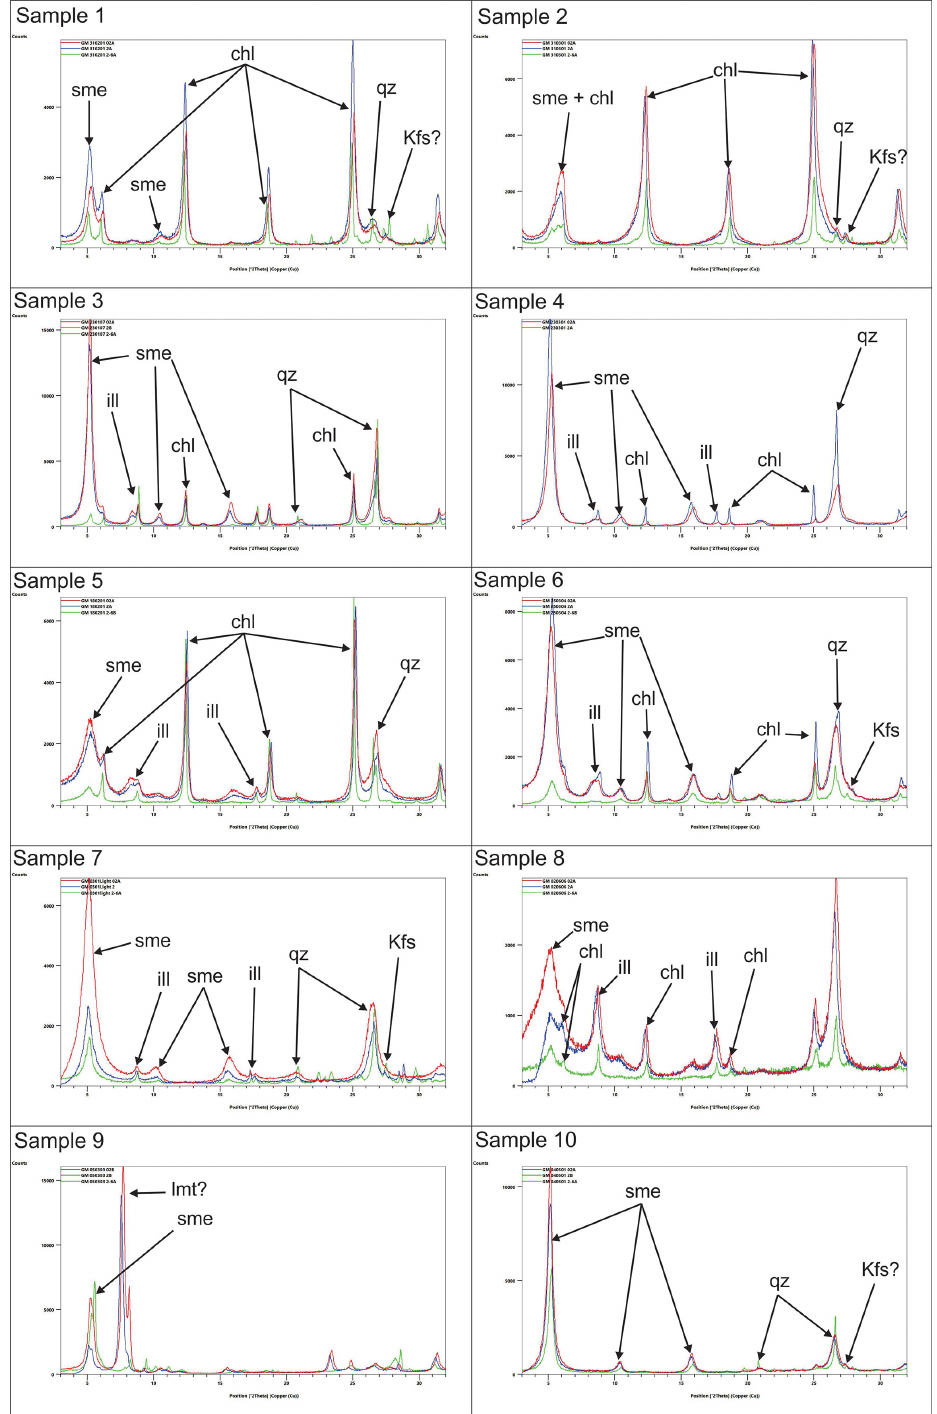
Figure A1. X-ray diffraction spectrum of copper graphs showing the mineralogical composition of the dated fault-rock samples. Green, blue and red lines, respectively, represent coarse, intermediate and fine grain-size fractions for each sample. Abbreviations are as follows: chl is chlorite; ill is illite; Kfs is K-feldspar; lmt is laumontite; qz is quartz; sme is smectite.